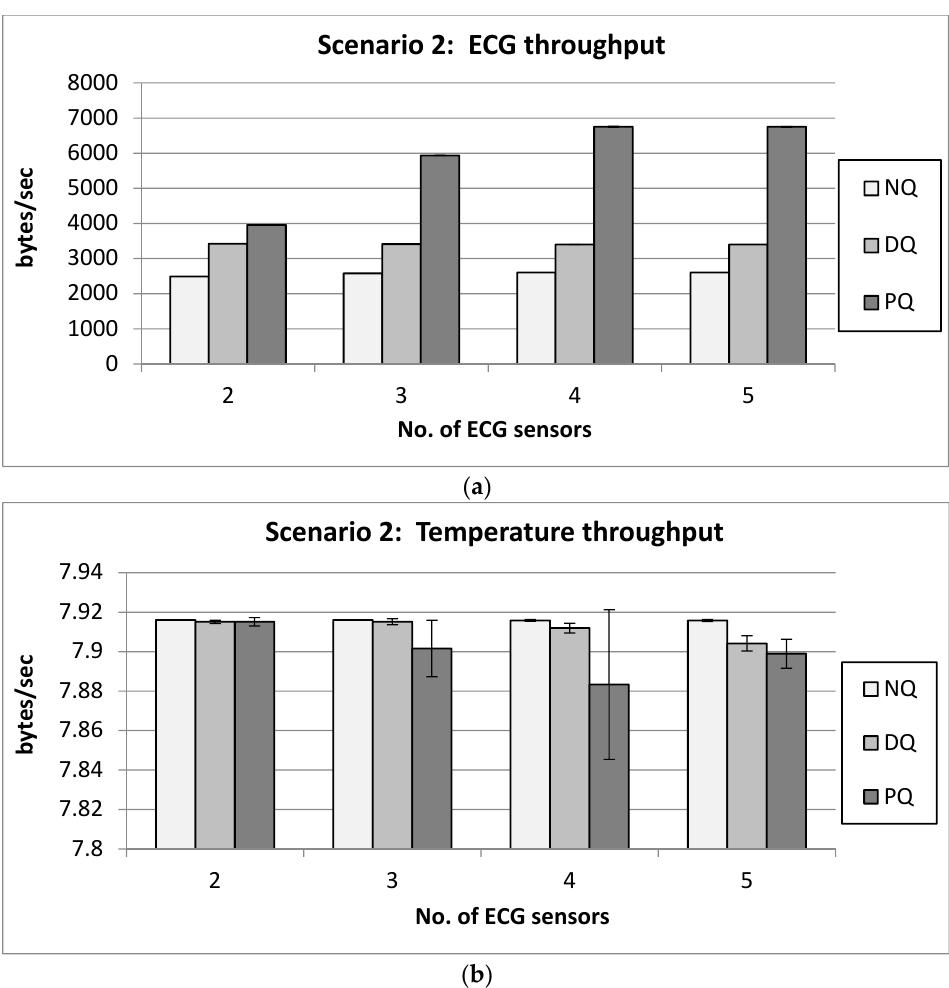
Figure 9. Average throughput results comparison for various data traffic types .